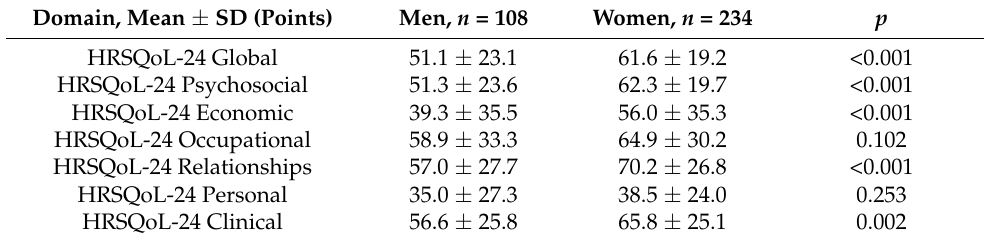
Table 2. Comparison of HSQoL-24 scores between genders.